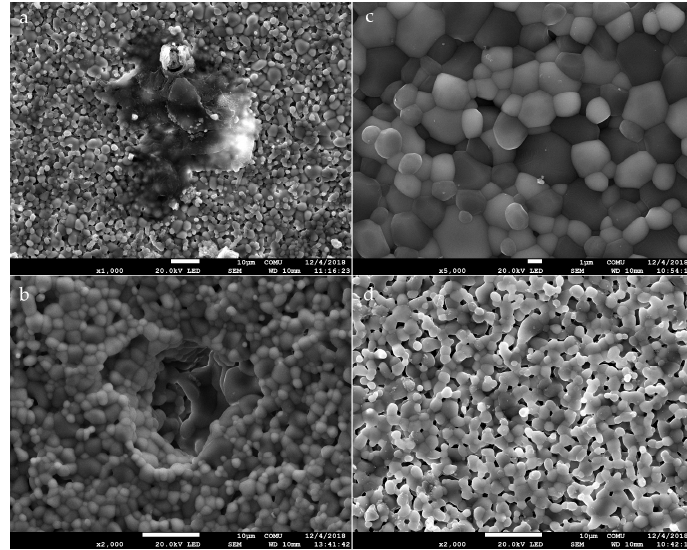
Figure 2. SEM photographs of microstructures of sintered composites: ( a ) 65AY, ( b ) 70AY, ( c ) 67AY, ( d ) 67AY.